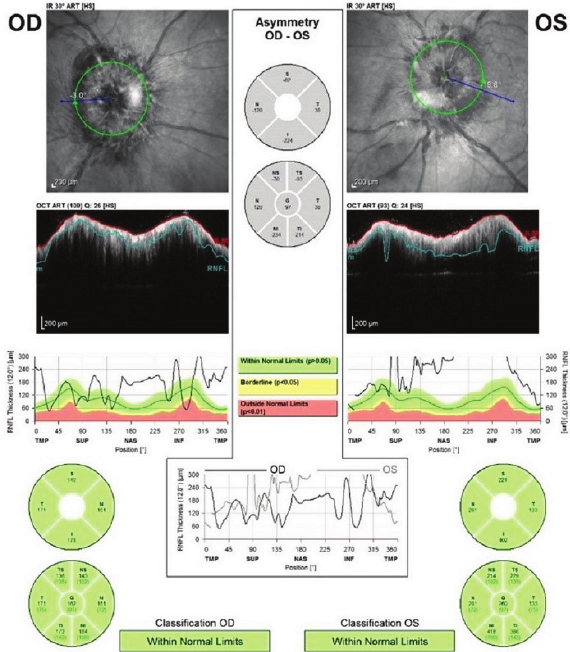
Figure 3. Spectral-domain optical coherence tomography shows increased reticular nerve fiber layer thickness in all four quadrants in both eyes, suggestive of disc edema.